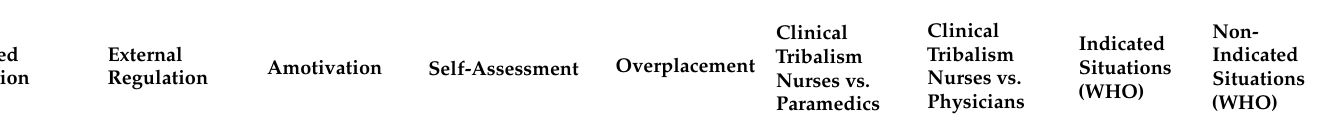
Table 2. Pearson’s product moment correlation matrix for hypothesis